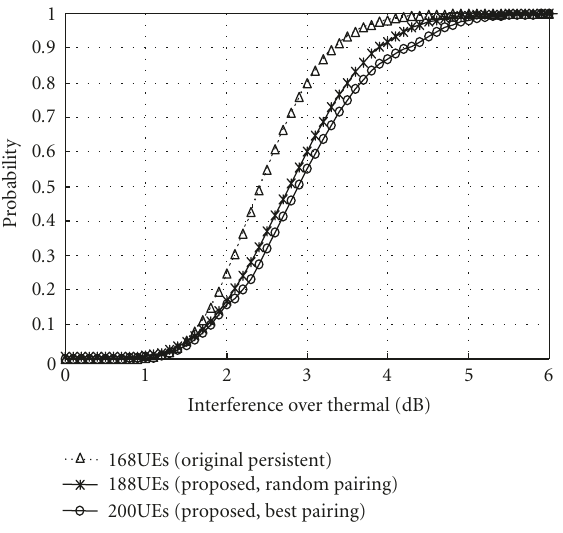
Figure 6: VoIP user IoT cumulative distributions.